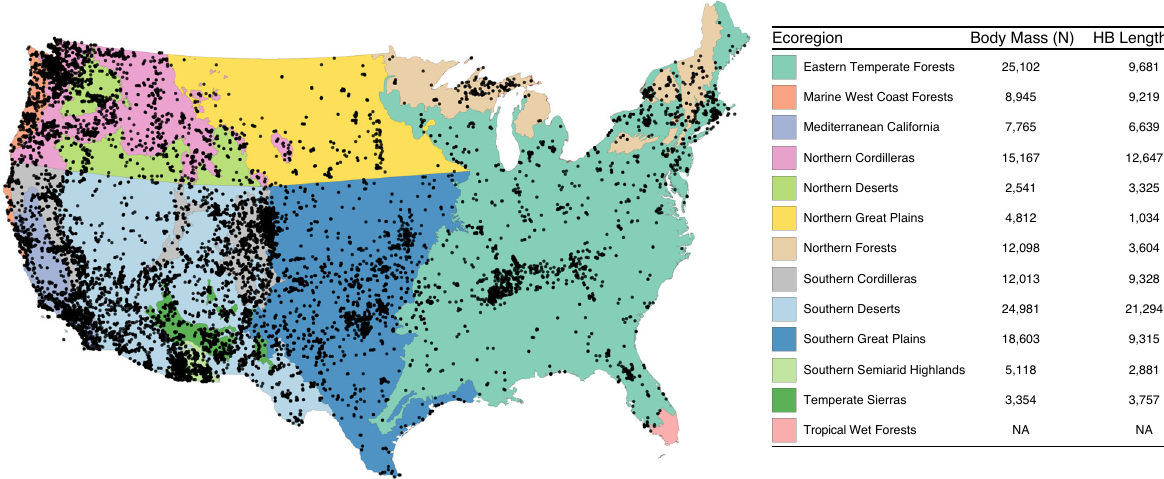
Fig. 1 Body mass and head-body (HB) length record localities. Designated spatial ecoregions are colored and the key shows the total number of body mass and head-body (HB) length records from each ecoregion. This map was created with R version 3.6.2